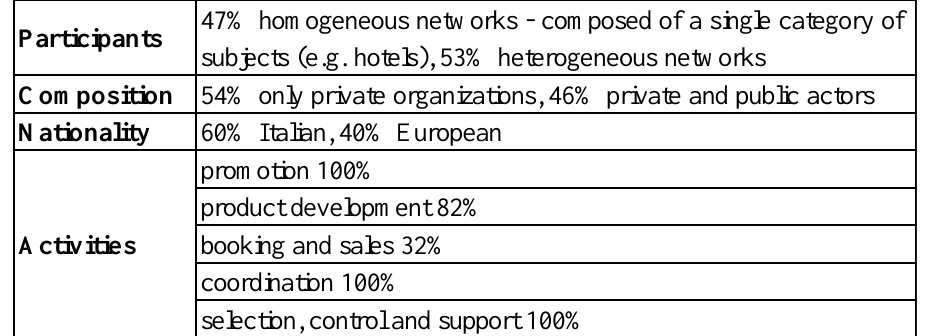
Table 3: Descriptive Analysis (frequencies)